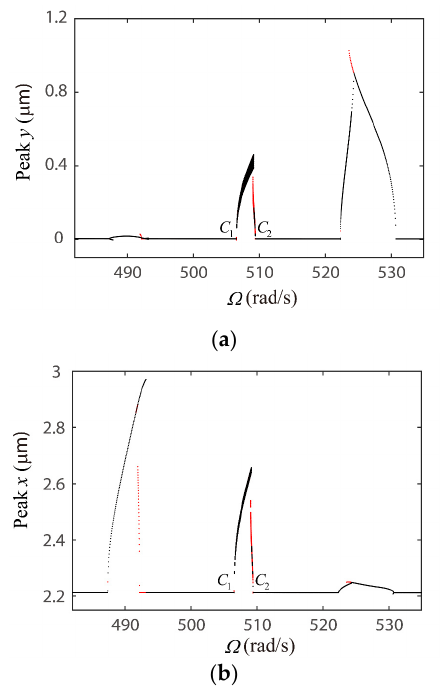
Figure 10. For δ 0 = − 1.5 μ m, numerical bifurcation diagrams of local-maxima ( a ) y ( τ ) and ( b ) x ( τ ) when Ω is sweeping up (black dots) and down (red dots).